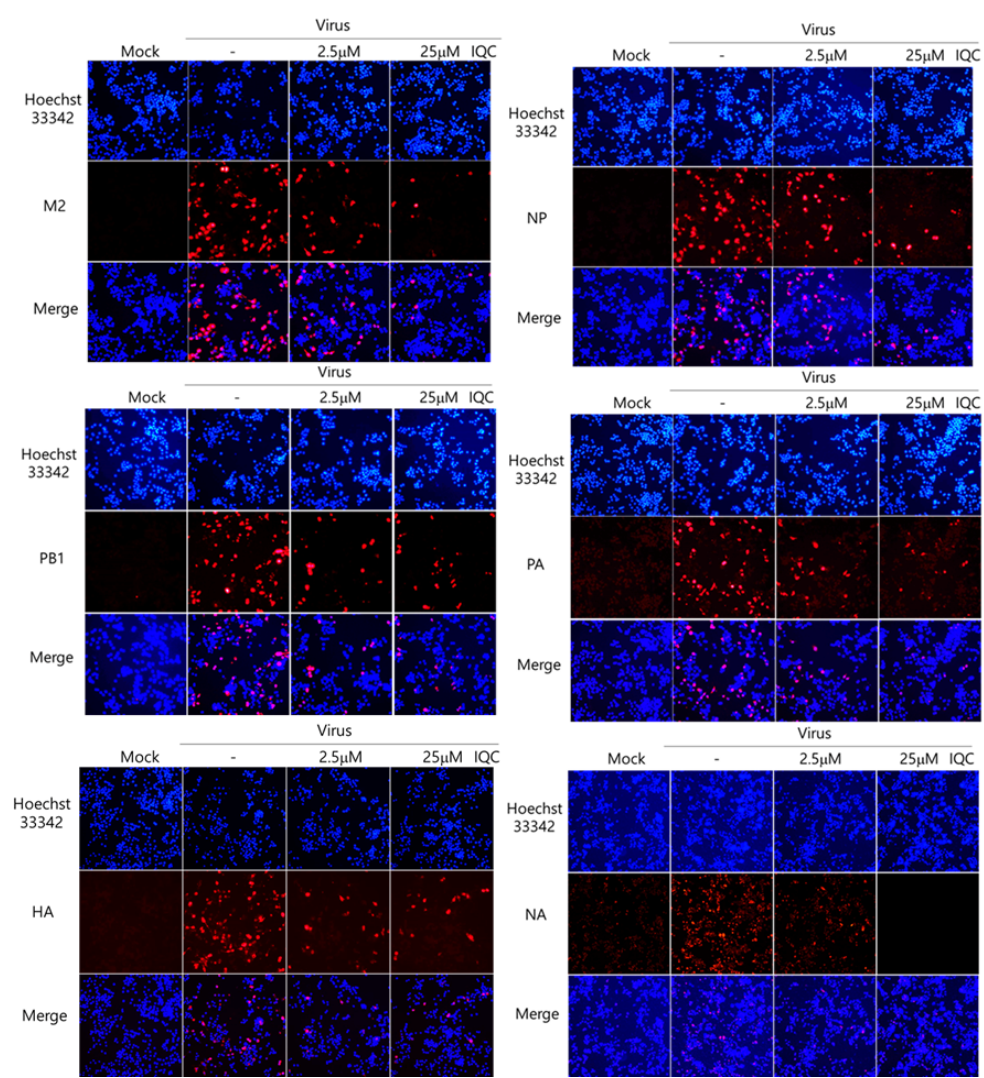
Figure 3. Isoquercitrin significantly decreased influenza A viral protein expression. PR8-GFP IAV at 10 MOI and 0, 2.5 µM, or 25 µM IQC were mixed and cotreated to the RAW 264.7 cells, as described in Figure 2. After fixing with paraformaldehyde at 24 h post-infection, the cells were immuno-stained with specific antibodies against M2, NP, PB1, PA, HA and NA (Red). The nuclei were stained in blue color with Hoechst 33342. The co-localization of viral proteins and nuclei was observed using a fluorescent microscope.